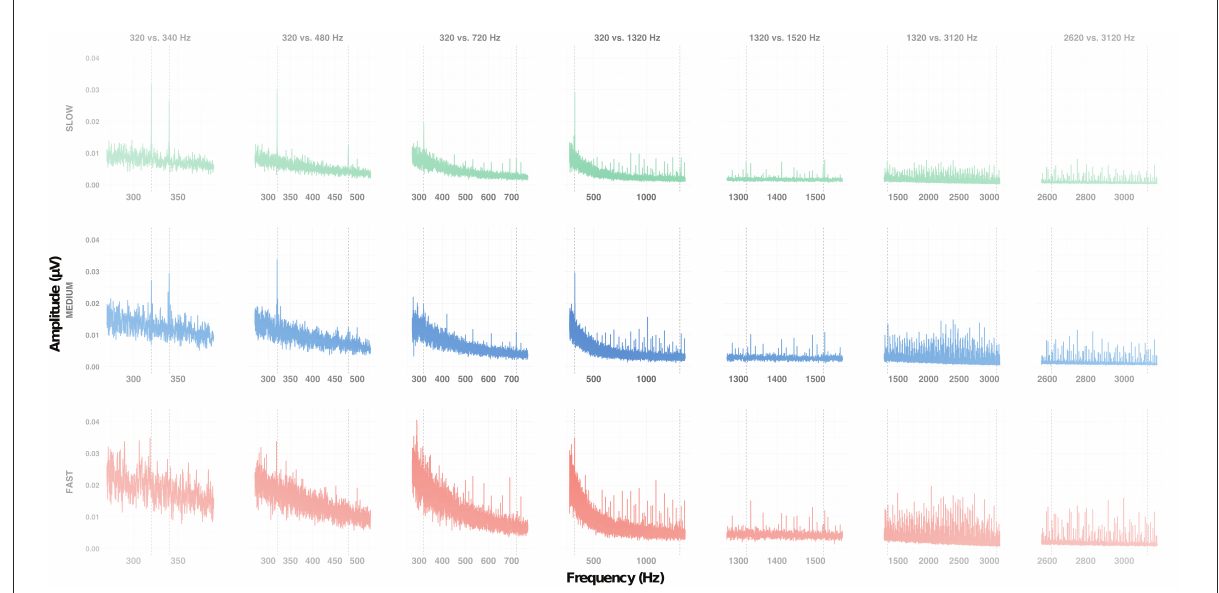
FIGURE2 Frequency response of the subcortical grand average responses at Cz, for each condition (columns) at each alternation rate (rows). Vertical dotted lines indicate the expected frequencies for each condition.